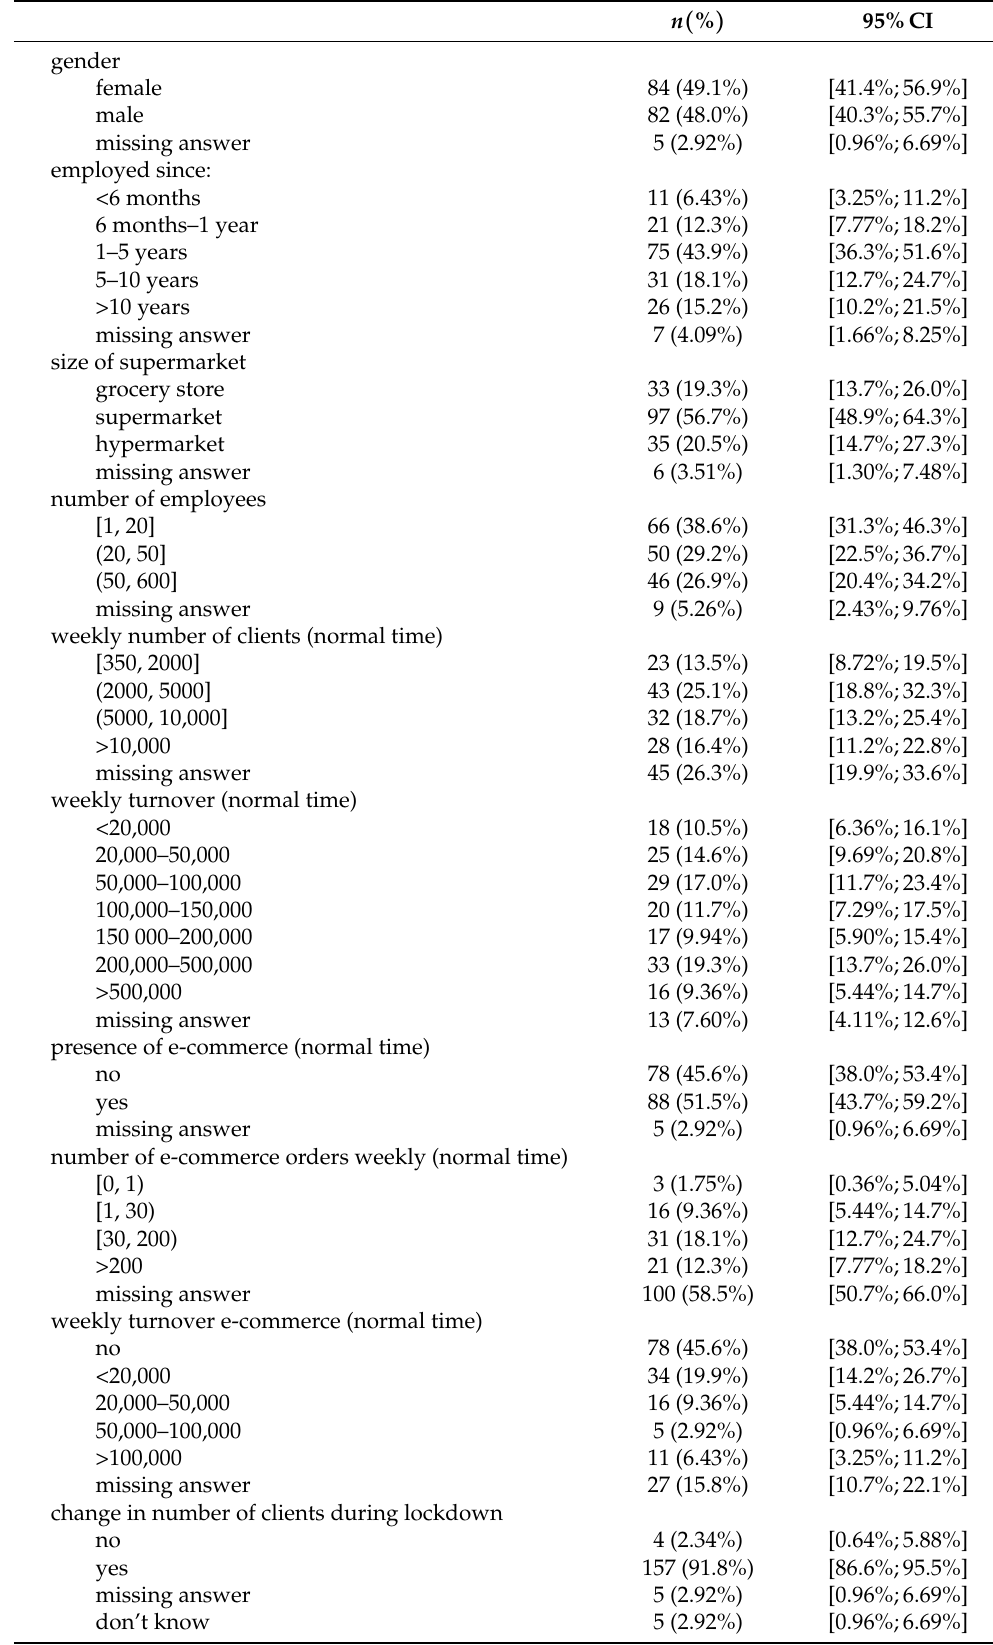
Table A3. Descriptive statistics for supervisors ( n = 171, a 95% confidence interval is